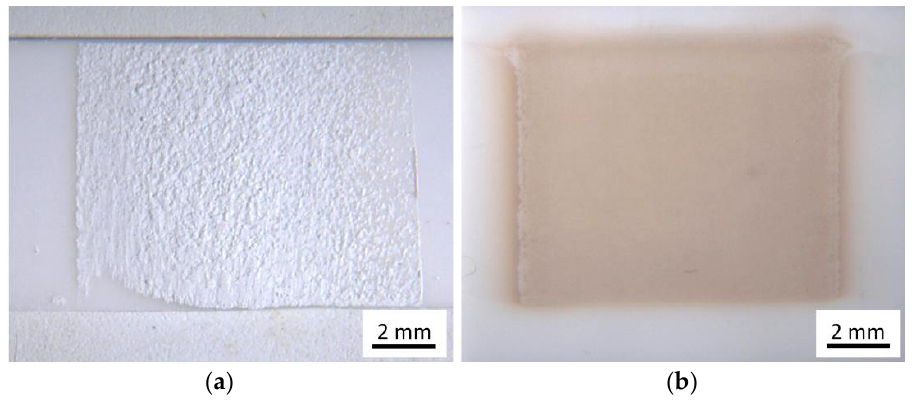
Figure 3. ( a ) Poor adhering and chalk-like AD film produced with untreated powder and ( b ) well adhering dense film deposited with temperature-treated and ball-milled powder before heat